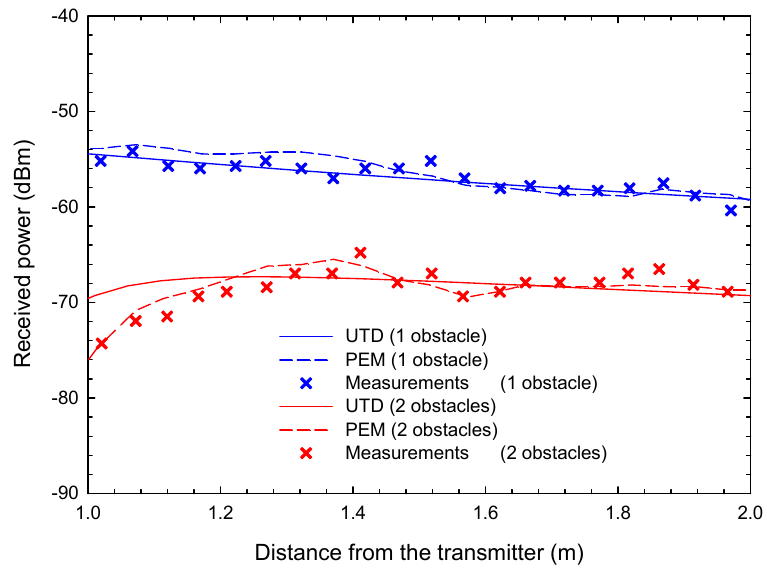
Figure 30. Comparison between the theoretical GO/UTD results for the first NLOS scenario and the measurements presented in [7].